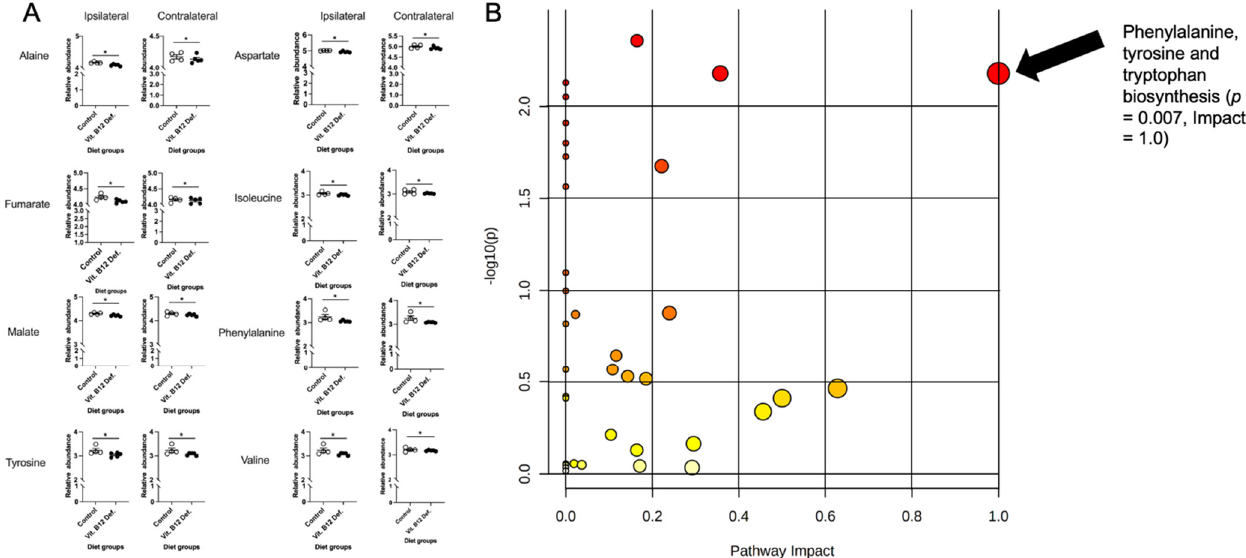
Figure 4. Impact of dietary vitamin B12 deficiency (vit. B12 def.) and ischemic stroke on mitochondria metabolomics in ipsilateral and contralateral brain tissue. Significance testing and enrichment analysis of metabolite data. Data were normalized to sample weight and log-transformed prior to analysis. ( A ) Significant between diet group metabolites (regardless of ischemic damage) as determined by two-way MANOVA: alanine ( p = 0.027), aspartate ( p = 0.019), fumarate ( p = 0.047), isoleucine ( p = 0.039), malate ( p = 0.013), phenylalanine ( p = 0.012), tyrosine ( p = 0.014), valine ( p = 0.030). ( B ) Pathway enrichment analysis performed using KEGG canonical pathways. Circle size denotes impact, whereas color corresponds to significance. Enriched pathways with p < 0.05 and impact > 0.50 have been labeled along with their p-values and pathway impact scores. * p < 0.05, un-paired t -test. Additionally, the measured metabolites were annotated using the Mus musculus KEGG reference database, and pathway enrichment analysis was performed between the